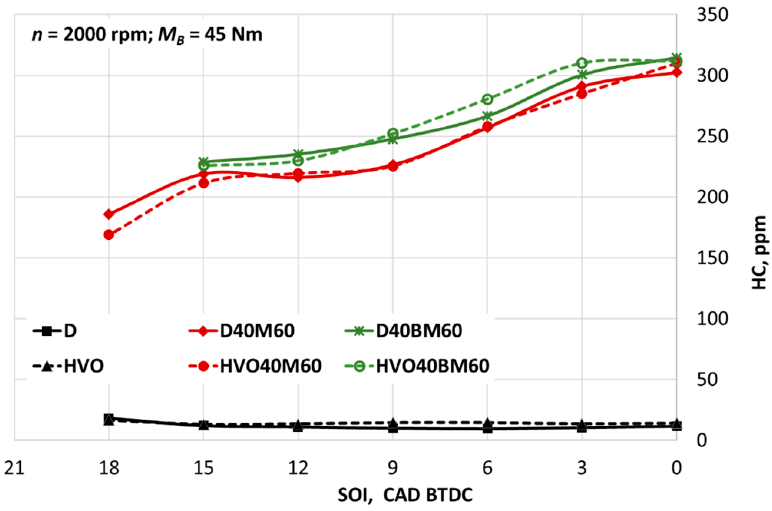
Figure 7. Change of HC volumetric fraction depending on fuel composition and SOI.